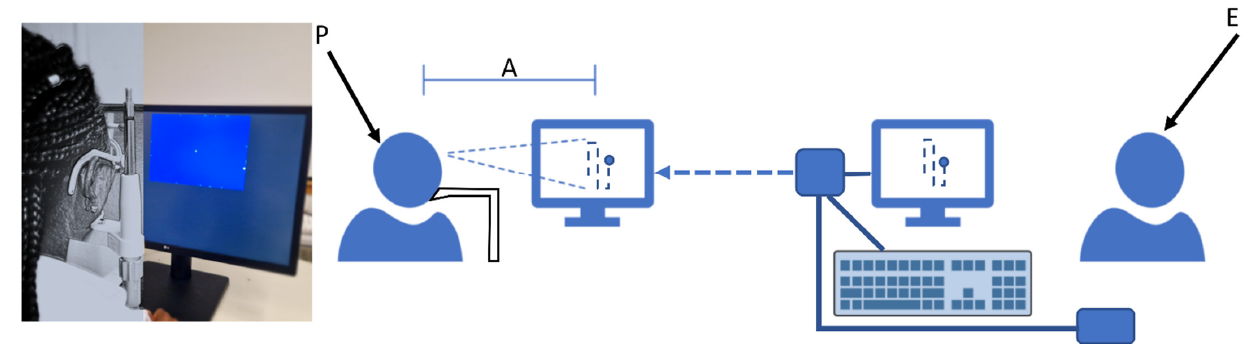
Figure 2. Rapid campimetry testing environment. Left Panel: Snapshot of the actual campimetry setting (with increased room lighting for better visualisation) with a volunteer fixating the centre of the testing area; left part of the image is masked to disable identification. Right panel: a sketch showing a person (P) looking at the monitor with a 40 cm distance (A) while an examiner (E) controls and runs the test on a different monitor. Table 2. Various test point sizes in relation to